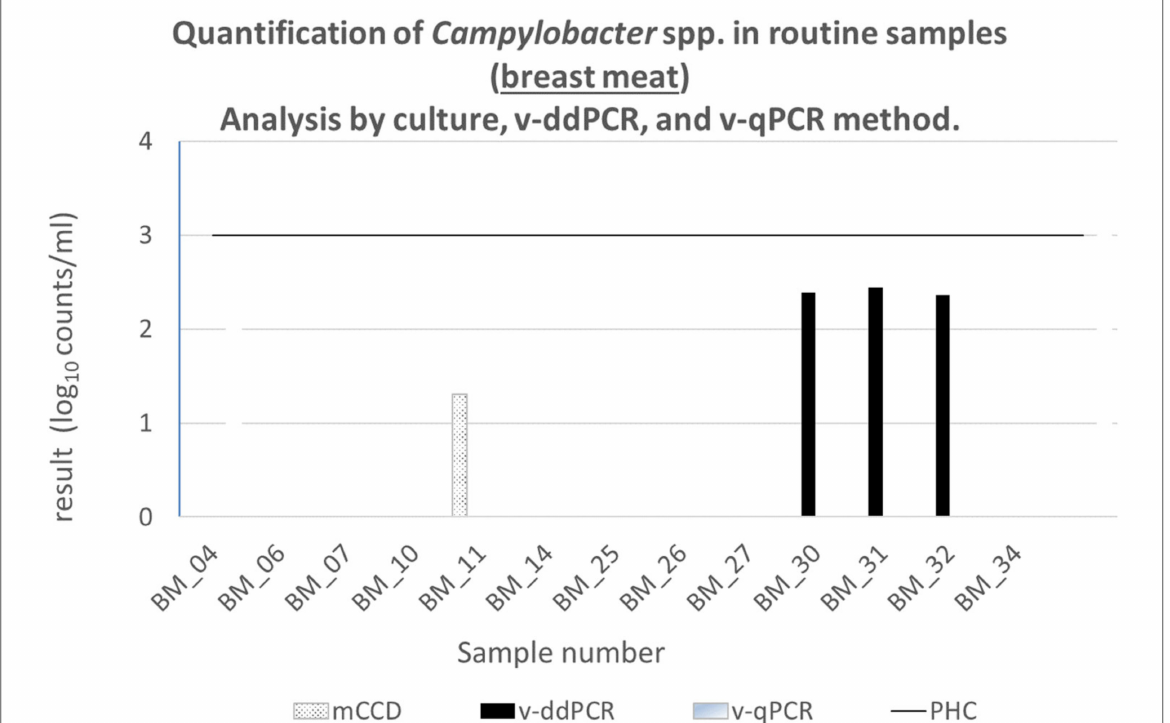
Figure 5. Analysis of LGL routine samples: chicken breast meat (BM) from retail. Analysis in culture, v-ddPCR and v-qPCR. The Process Hygiene Criterion (PHC: log 10 3.0) is marked with a black